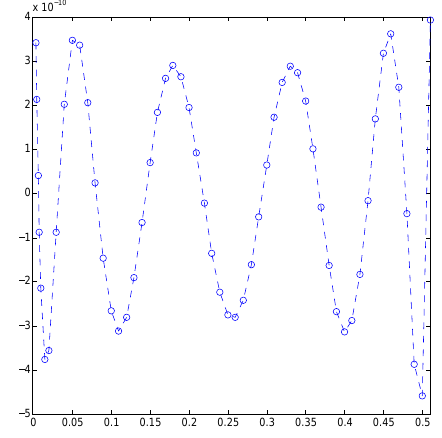
Fig. 2: The absolute errors of interpolation correspond to the coe(cid:30)cient g N Z, 5 , 0 ( d c ) (right) in function of d c in the case Z = A